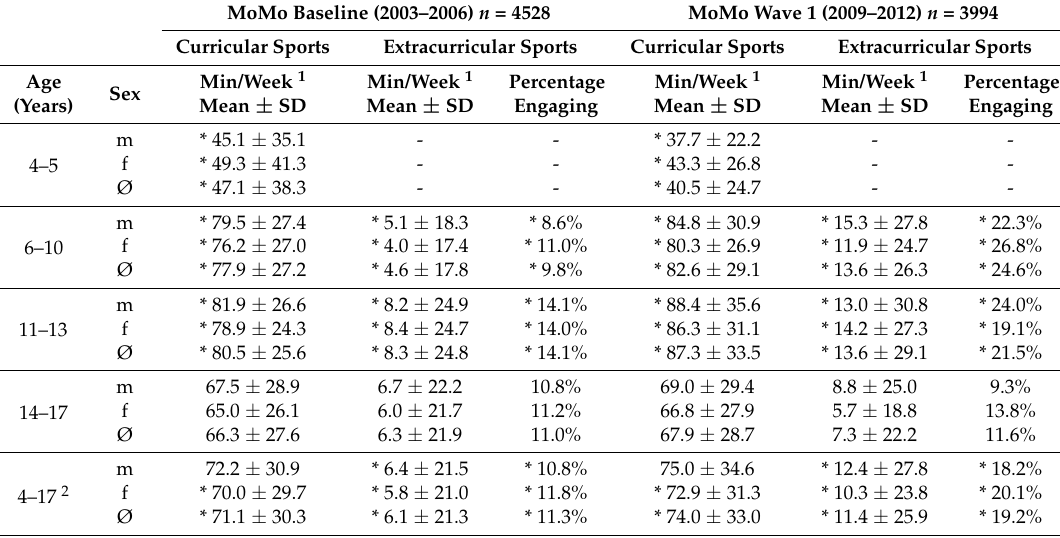
Table 1. Physical activity (PA) of German children and adolescents in setting